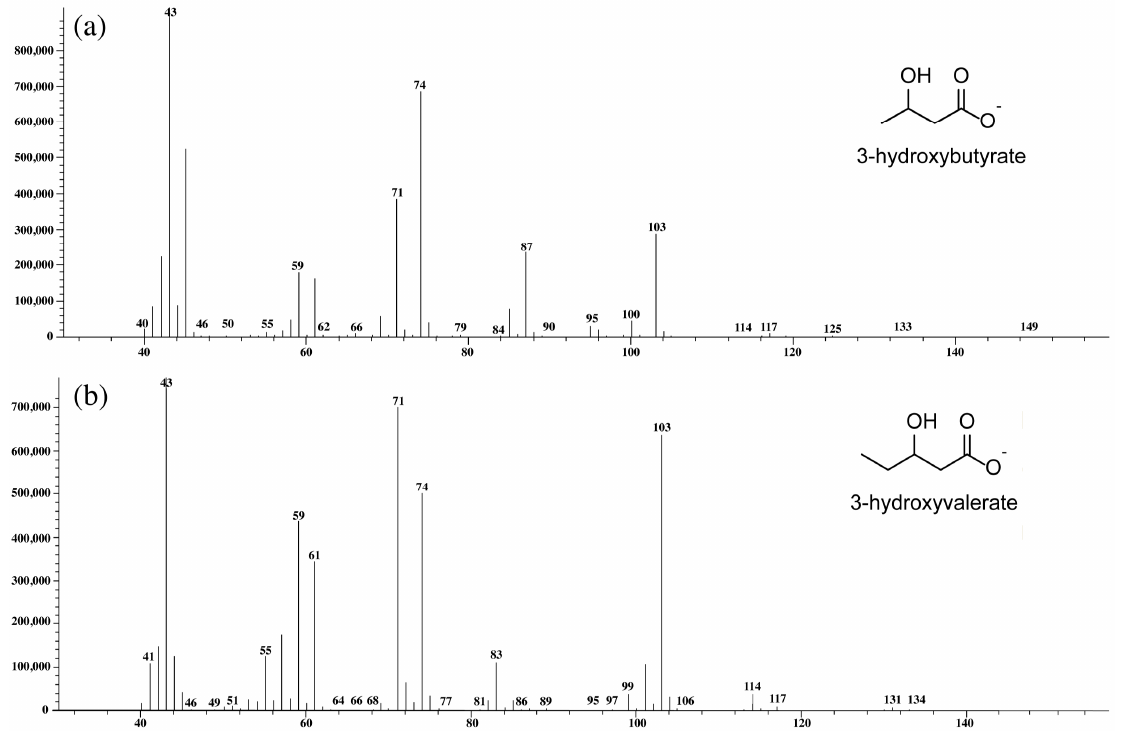
Figure 6. Mass spectrometry analysis of PHBV extracted from Cyanosarcina sp. AARL T020. The ( a ) 3-hydroxybutyrate (3HB) subunit and ( b ) 3-hydroxyvaryrate (3HV) subunit were compared with the mass spectra MS library (NIST 11).